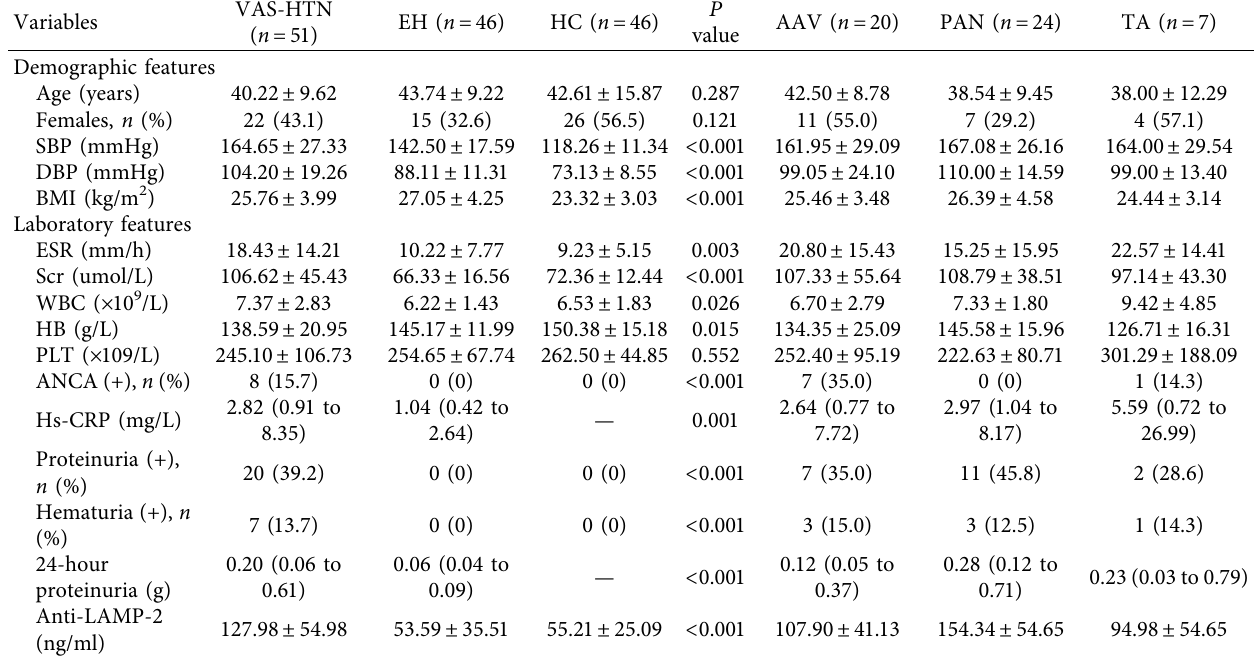
Table 1: Demographic and laboratory features.